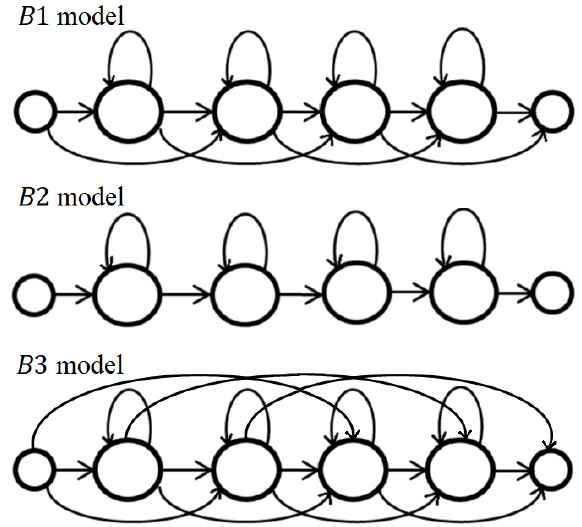
Figure 4. The state transitions diagrams of exemplary four-state models B 1, B 2, and B 3. Smaller circles represent non-emitting